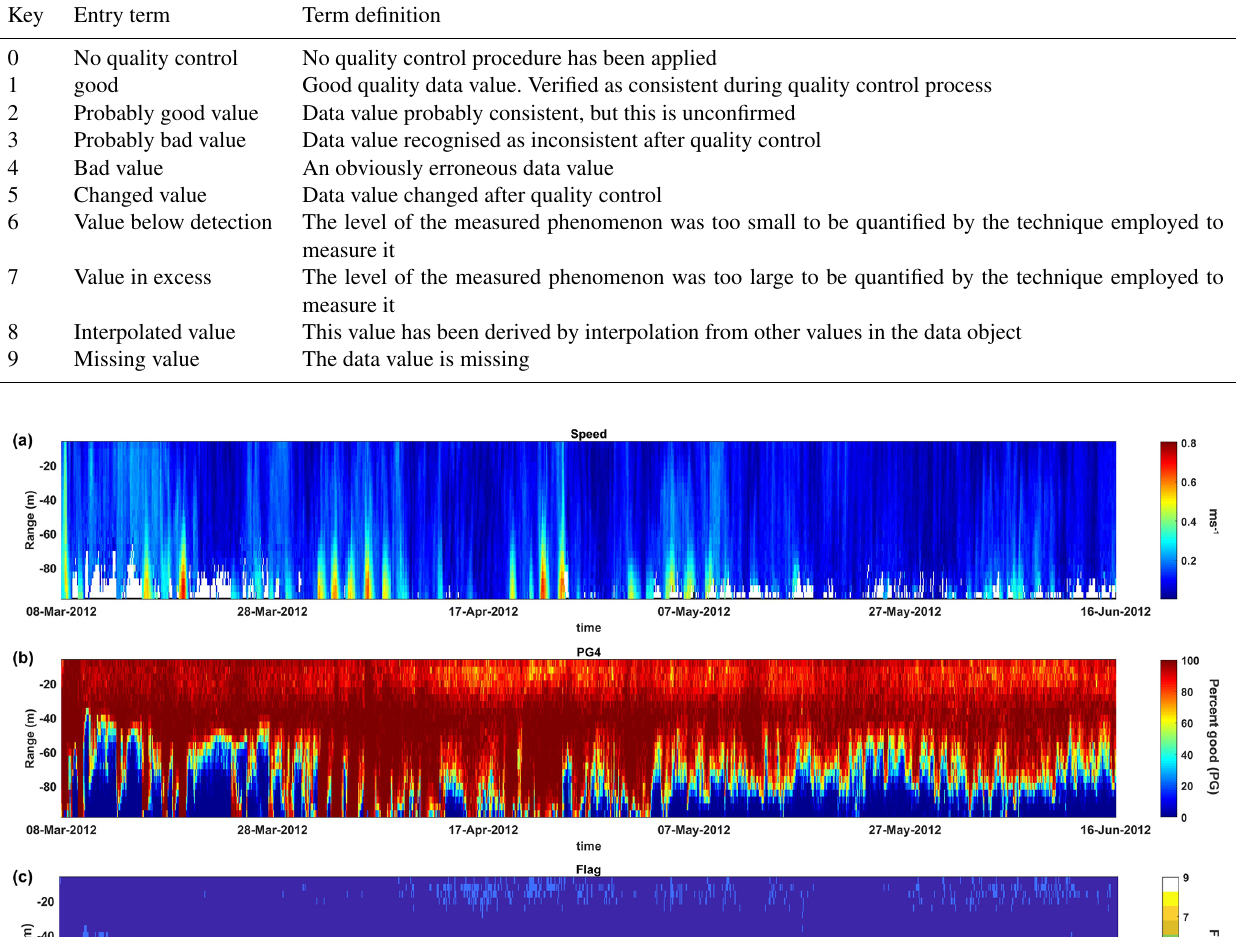
Table 3. The qualifier flag codes relevant to this work are given in the table. The full list is available at the following address: http://seadatanet.maris2.nl/v_bodc_vocab_v2/browse.asp?order=conceptid&formname=search&screen=0&lib=l20, last access: 7 Decem- ber 2022.